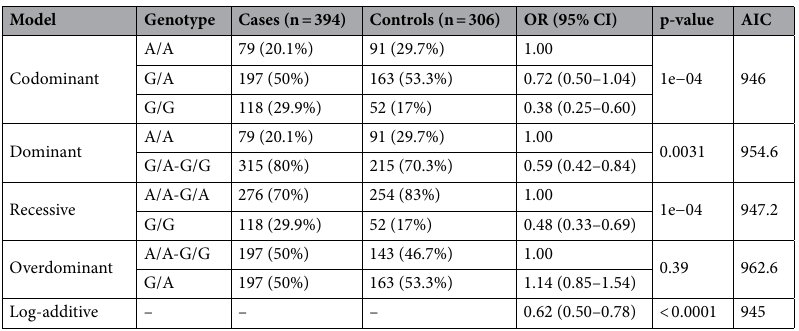
Table 2. Genotypic association between PCOS and control women based on different inheritance model using Akaike Information Criterion (AIC).